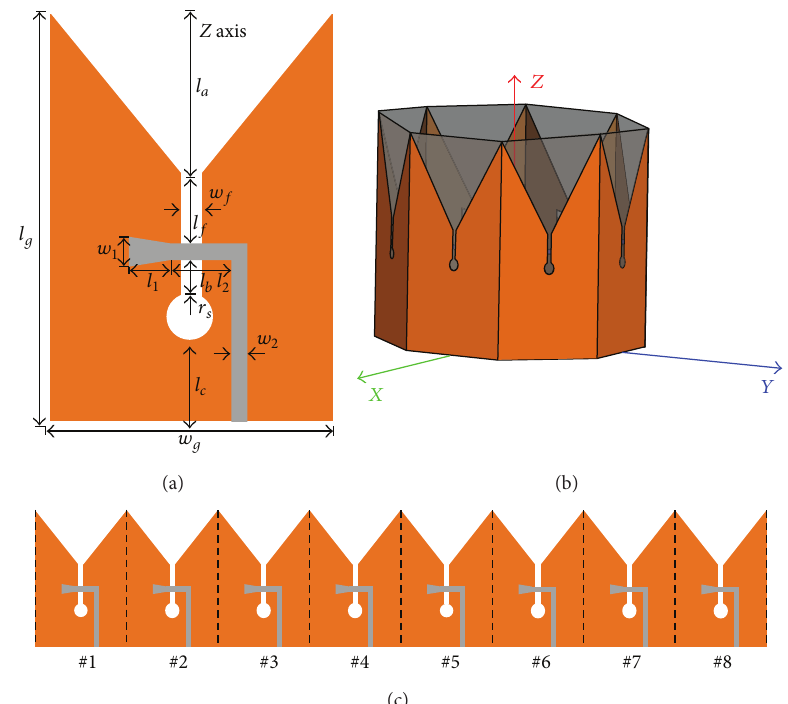
Figure 1: Geometry of the proposed antenna: (a) Vivaldi antenna element; (b) Vivaldi circular antenna array; (c) the unfolded view of the antenna array.